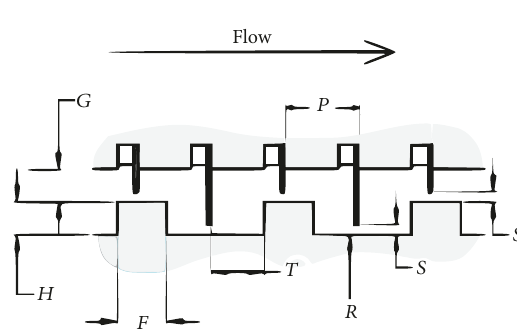
Figure 3: Staggered seal geometry.